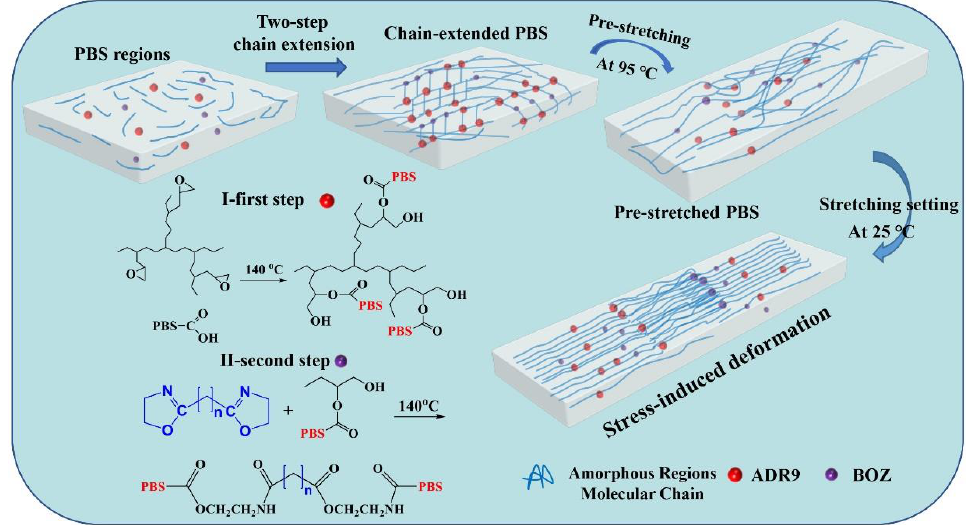
Figure 1. Mechanism diagram of collaborative chain extension of PBS.